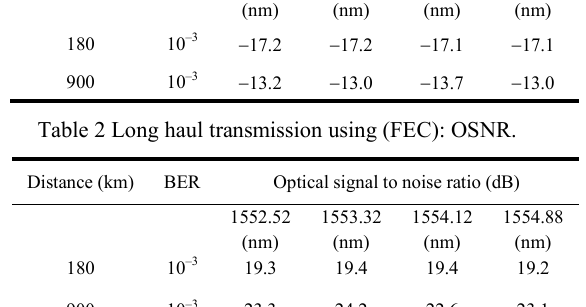
Table 1 Long haul transmission using (FEC): ROP. Distance (km)